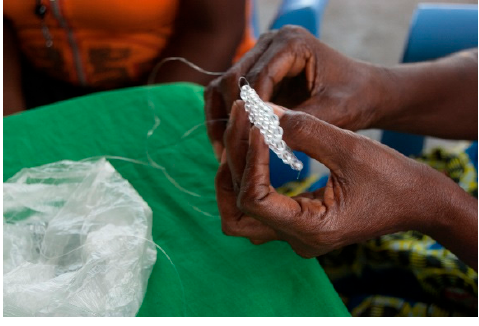
Figure 6. Threading beads.